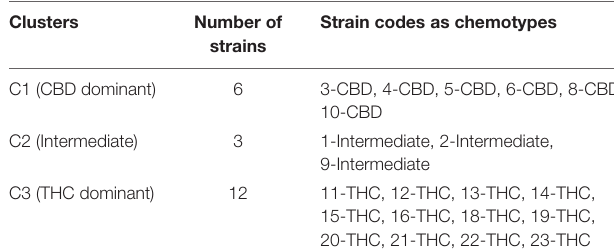
TABLE 1 | Preassigned chemotypes as the working groups for canonical correlation analysis .